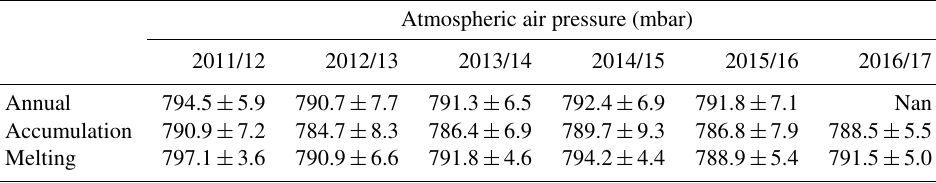
Table 3. Mean and standard deviation of atmospheric air pressure for the five snow seasons for the annual, accumulation and melt periods.